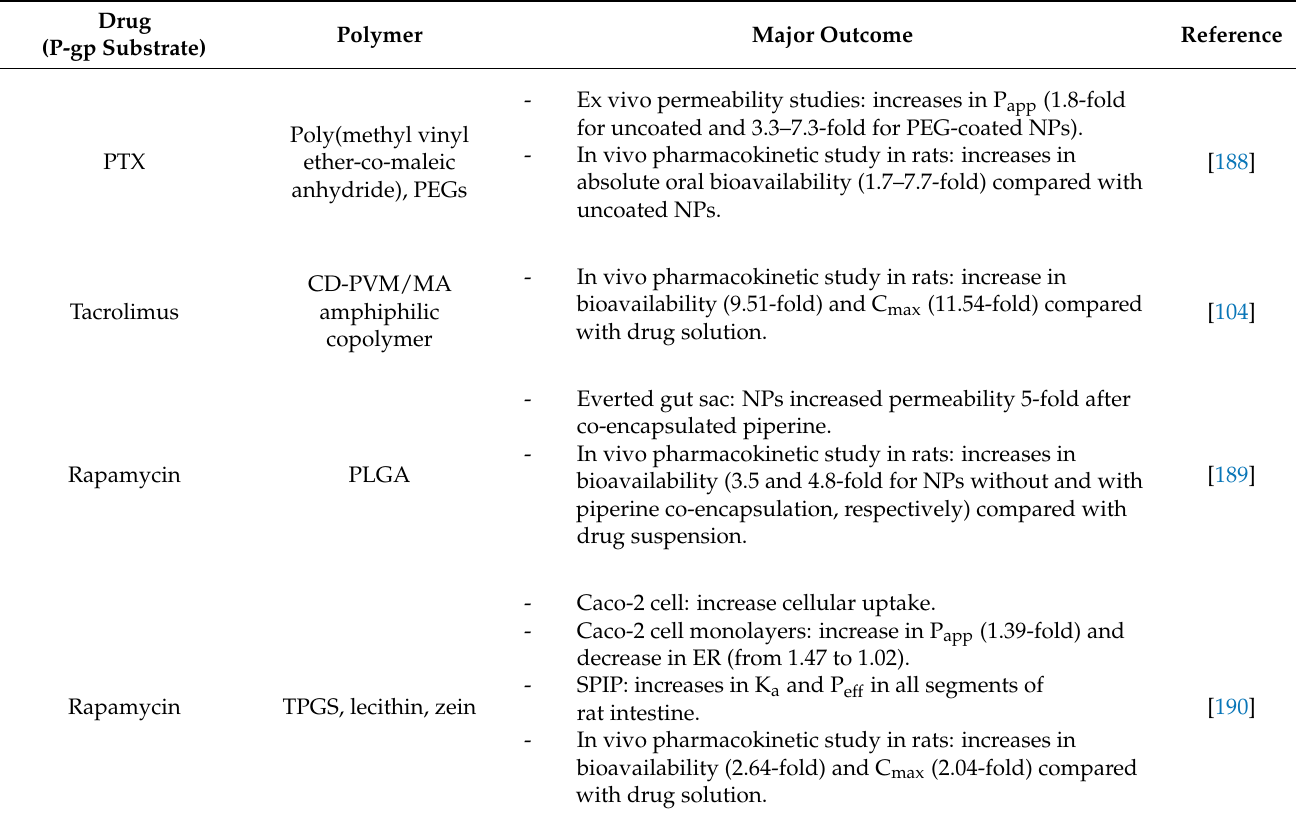
Figure 6. Effects of polymeric NPs on ( a ) intestinal absorption and ( b ) pharmacokinetic properties in rats of docetaxel (DTX). * p < 0.05, ** p < 0.01. Reprinted from [195] under the terms of the Creative Commons Attribution License. Features of the aforementioned polymeric NPs are summarized in Table 5. Table 5. Polymeric nanoparticles with P-gp inhibitory